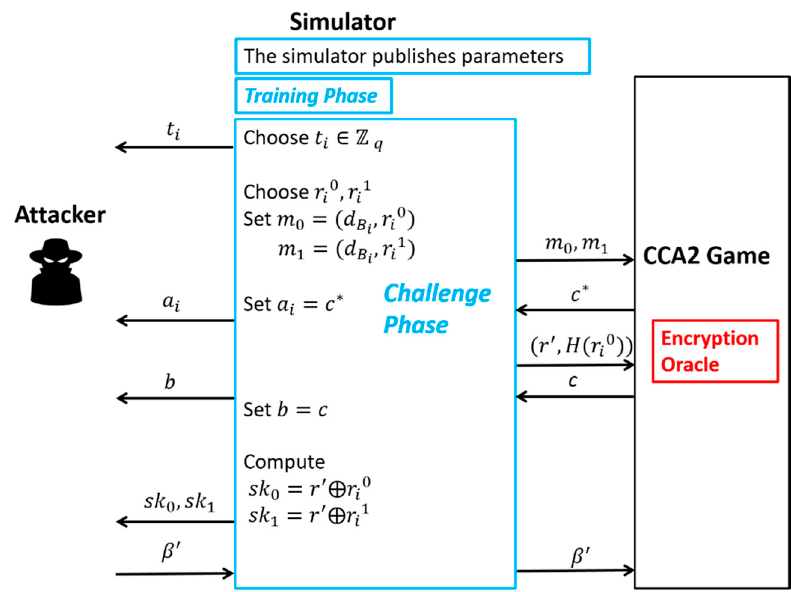
Figure A7. The session key security ( Q (cid:48) = 1 )